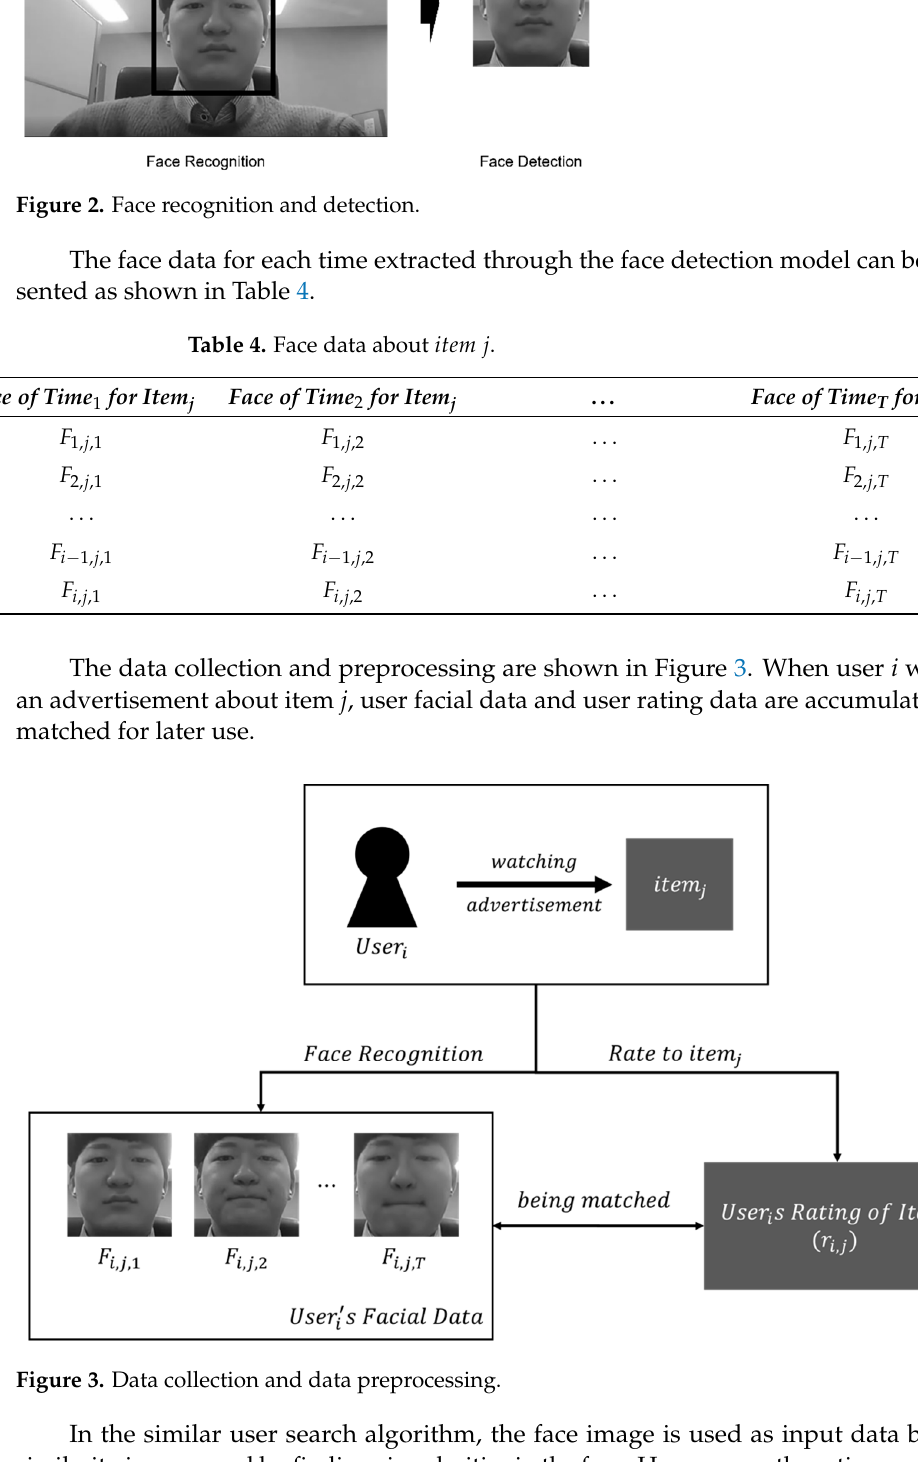
Figure 3. Data collection and data preprocessing.